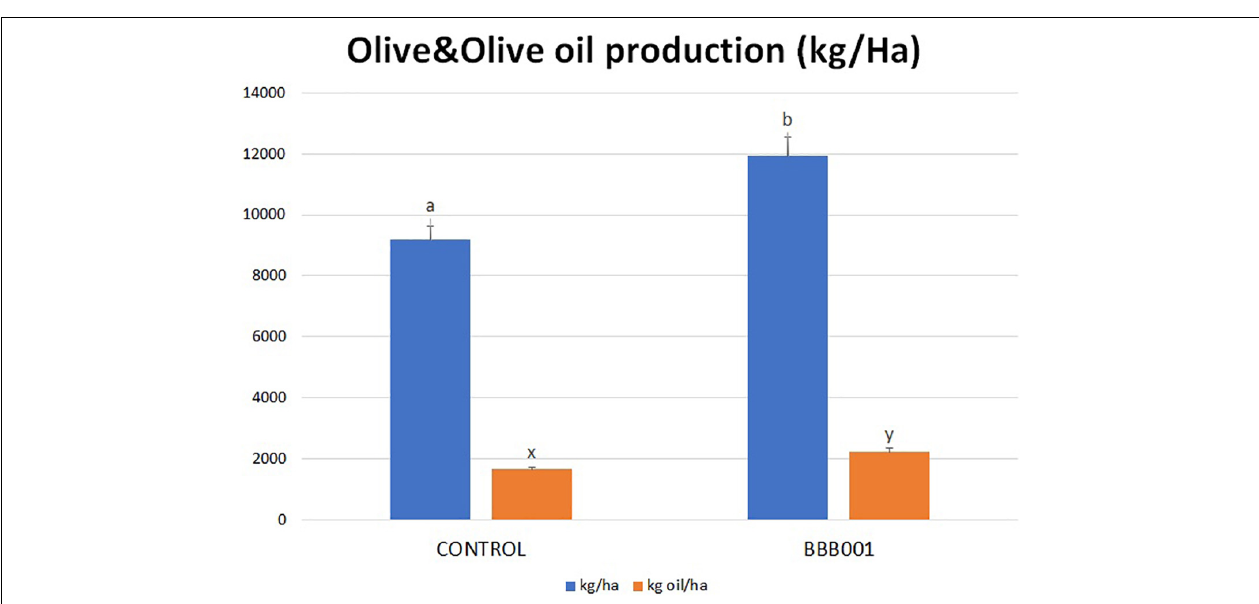
FIGURE 5 | Olive and olive oil production of Olea europaea trees (kg/ha). Different letters denote statistically significant differences according to LSD test ( p < 0.05) for olive yield (a, b), oil yield (x, y).